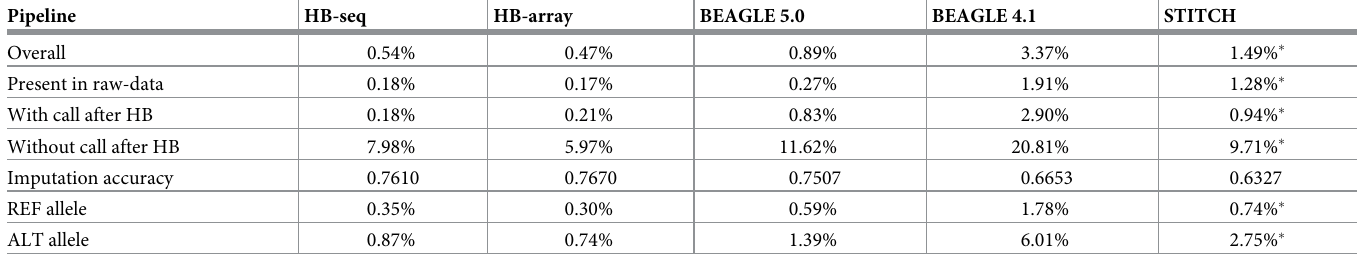
Table 1. Discordance rates between the imputed sequence data and the 600k array data depending on the used imputation pipeline. � For cells with a genotype call in STITCH itself, discordance rates were only 0.39% compared to 0.44 / 0.39% for HB-seq / HB-array for the same entries.